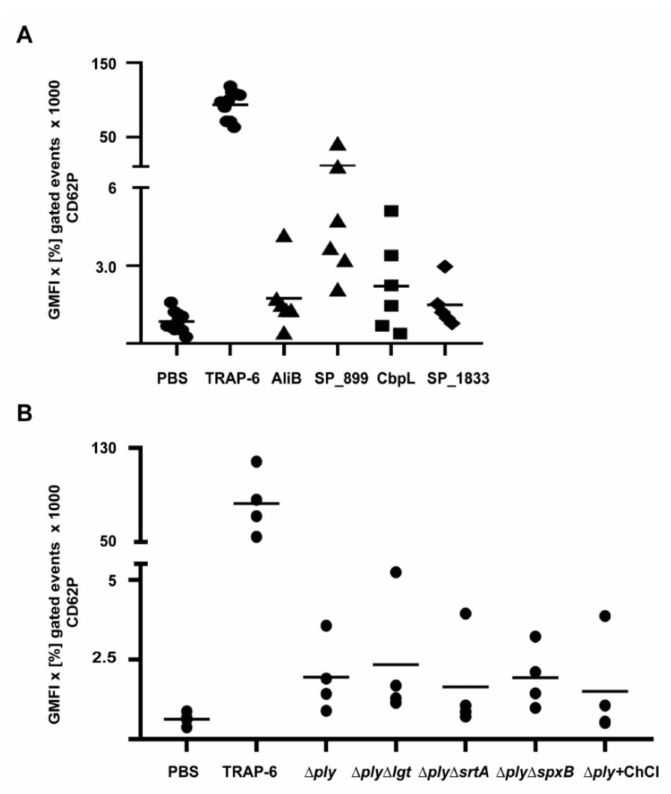
Figure 5. Individual pneumococcal proteins and pneumococcal lysates directly activate human platelets. Washed platelets of a defined set of donors were incubated with different concentrations of pneumococcal proteins ( A ) (Table 1) for 30 min or pneumococcal lysates ( B ) with the indicated genetic backgrounds for 60 min at 37 ◦ C. CD62P was used as an activation marker and was